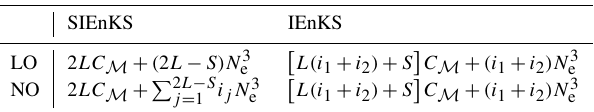
Table 2. Order of the MDA cycle flops for lag = L = Q × S , shift = S , tuned inflation, linear observation operator (LO), or nonlinear observation operator (NO).